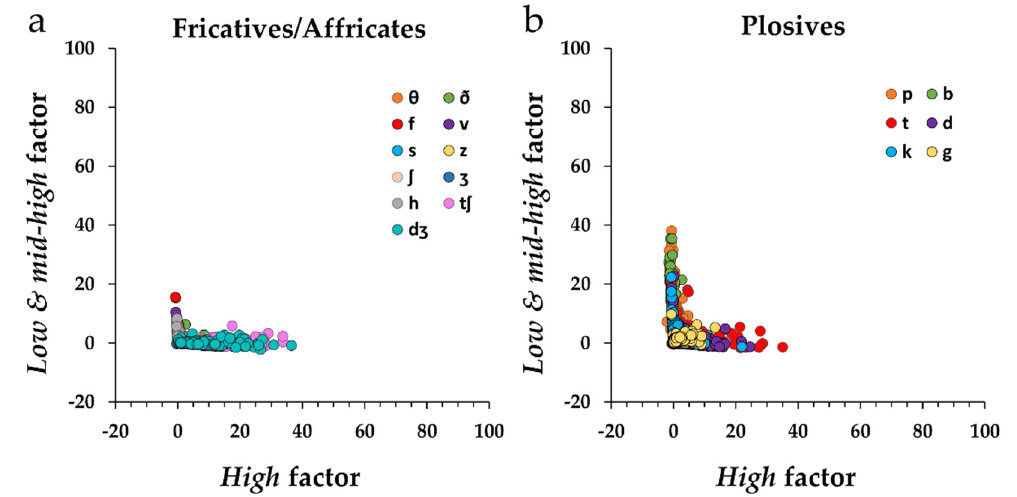
Figure 7. The L-shaped distributions of obstruents divided into fricatives/affricates ( a ) and plosives ( b ) in the two-dimensional space of the “low & mid-high factor” and the “high factor”. Factor scores of the three extracted spectral factors were obtained by origin-shifted factor analysis with cepstral liftering (cf. Figure 2) and the English speech samples were from three native speakers.